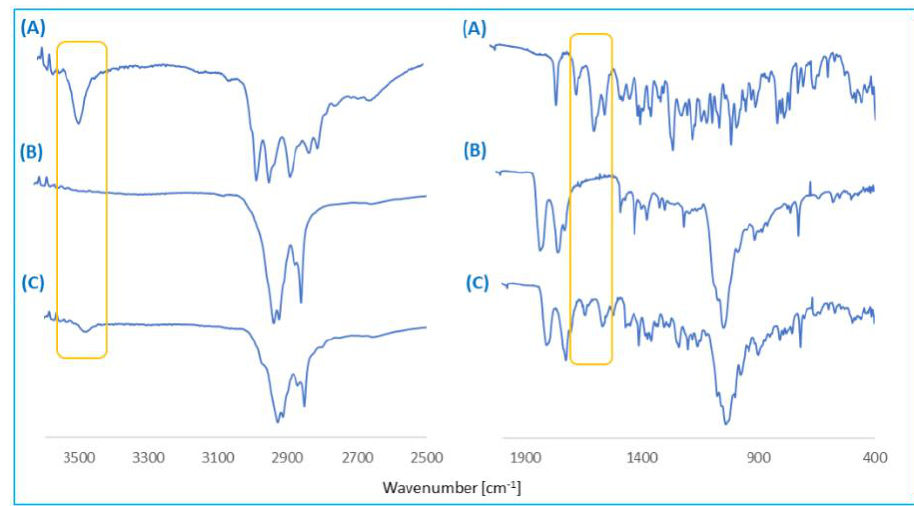
Figure 9. FT-IR spectra of rifampicin ( A ), copolymer ( B ) and rifampicin-loaded microspheres ( C ).